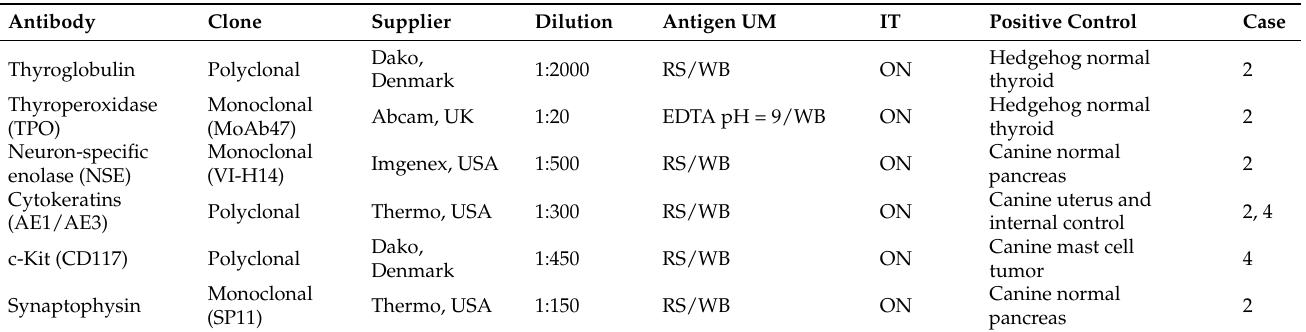
Table 2. Details about the protocol and antibodies used for immunohistochemical